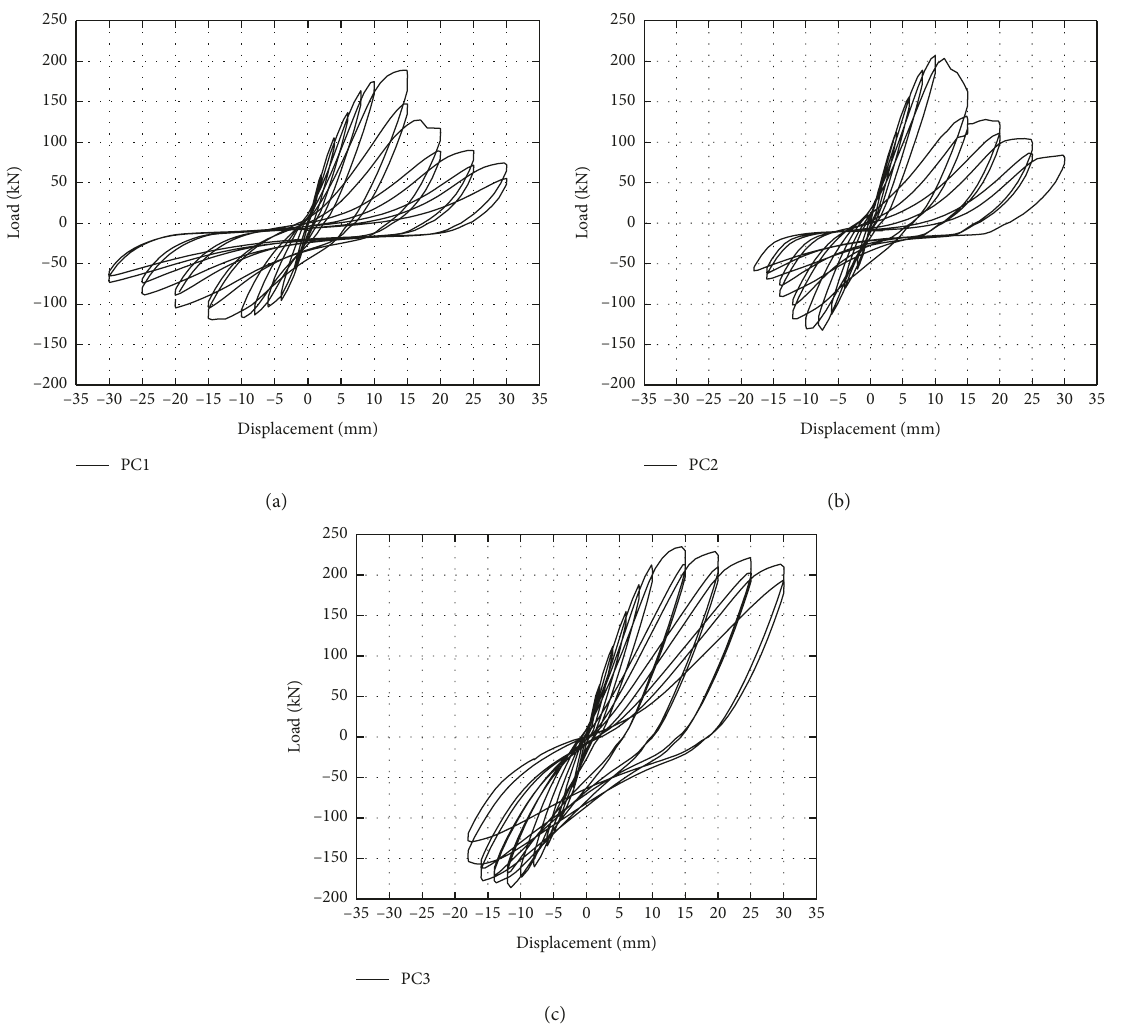
Figure 7: Hysteresis curves of the specimens. (a) PC1. (b) PC2. (c)